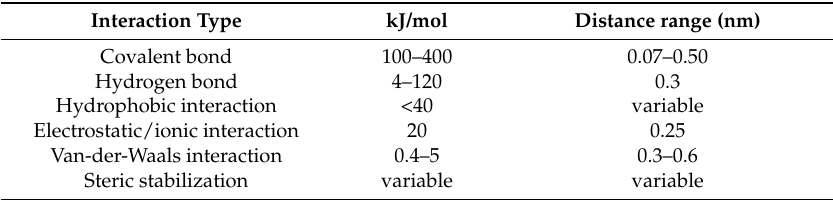
Table 1 . Strength and characteristic ranges of the main soft interactions. Table 1. Strength and characteristic ranges of the main soft